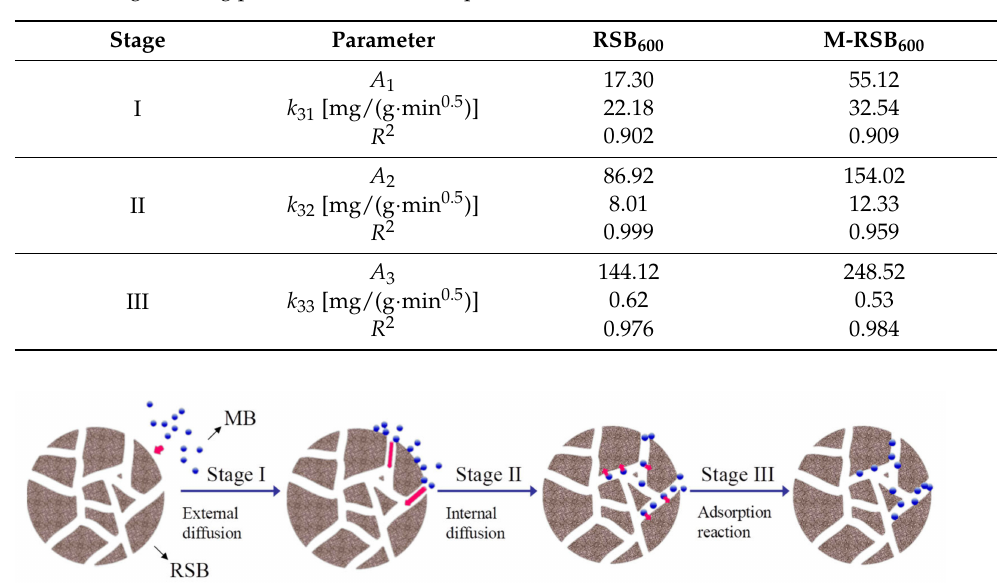
Figure 10. Staged fitting of intraparticle diffusion. Table 4. Staged fitting parameters of the intraparticle diffusion model.